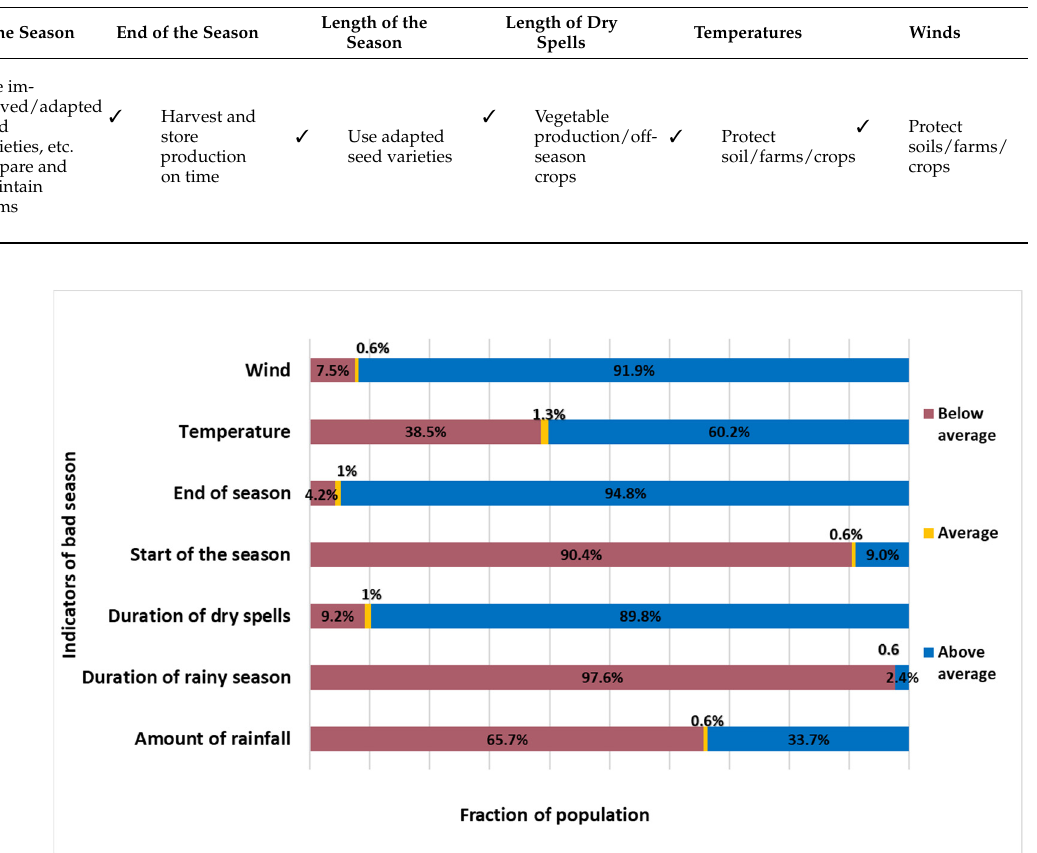
Figure 9. Community indicators of a bad season (year): brown = above average; yellow = average and Blue = Below average.